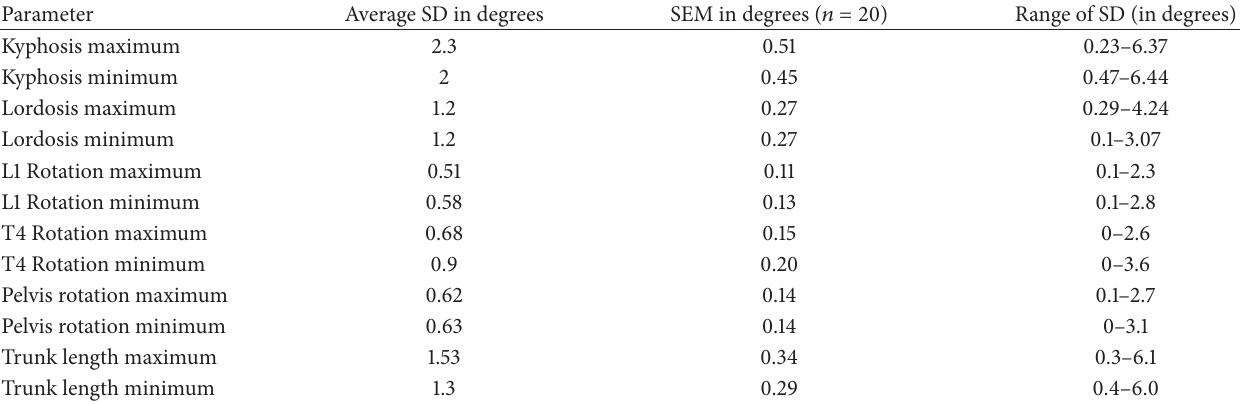
Table 2: Average standard deviations, standard error of the mean, and range for spinal parameters